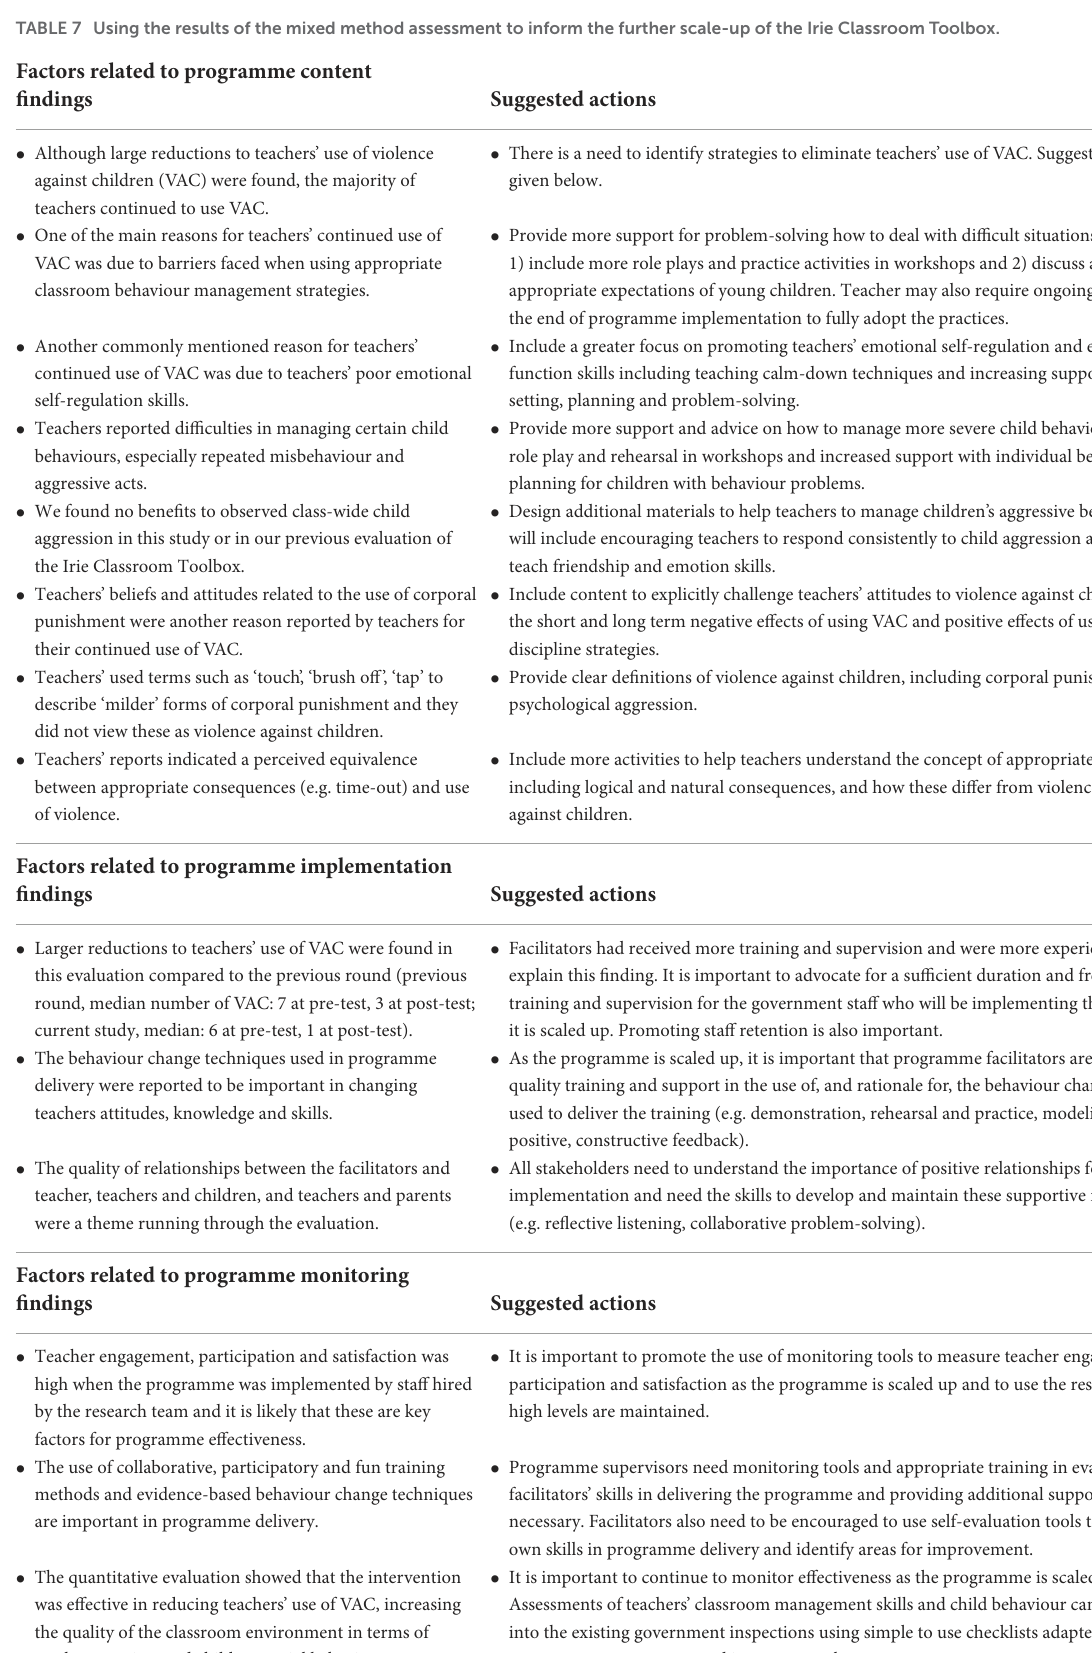
TABLE 7 Using the results of the mixed method assessment to inform the further scale-up of the Irie Classroom